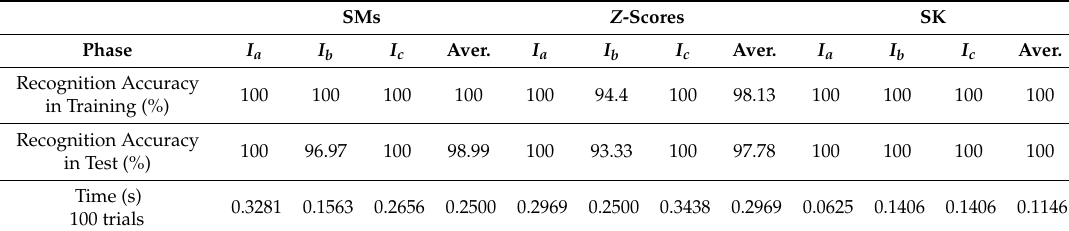
Table 6. Results of SLGF on the bus faults with the SVM.